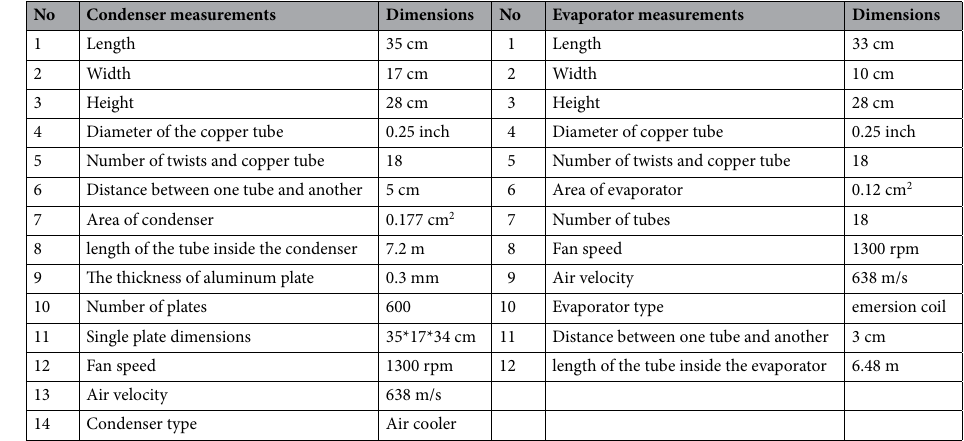
Table 3. Dimensions and characteristics of both the condenser and evaporator.